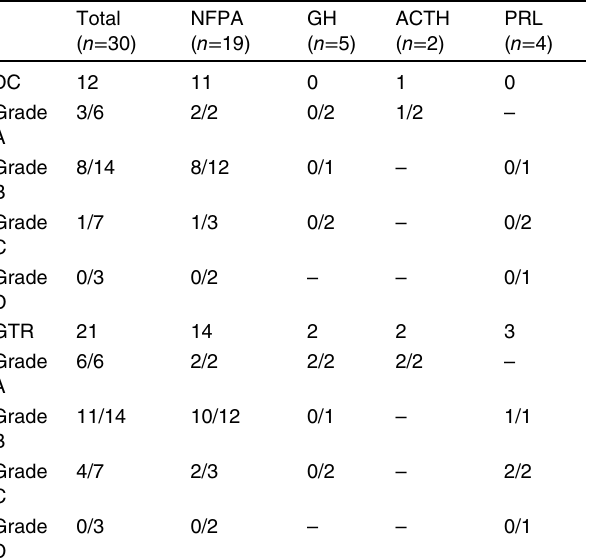
Table 7 Surgical outcome of pituitary adenomas with cavernous sinus